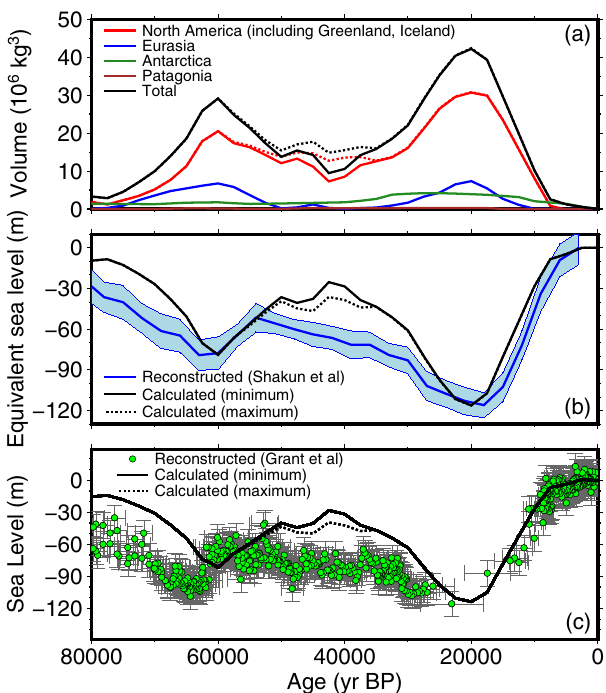
Fig. 2 Relations between ice sheet volume and sea level in the reconstruction. The solid line represents the minimal MIS 3 scenario, while the dotted line is the maximal MIS 3 scenario. a Ice sheet volume. b Calculated ice-volume equivalent sea level, compared with the global seawater δ 18 O stack 41 (blue line with 2 σ error range), converted to sea level using a value of − 116 m for the maximum sea-level drop. c Comparison of sea-level calculated at the outlet of the Red Sea and a sea-level reconstruction 40 based on planktonic foraminifer δ 18 O, with chronology corrected to match an eastern Mediterranean speleothem record (green dots with 2 σ error